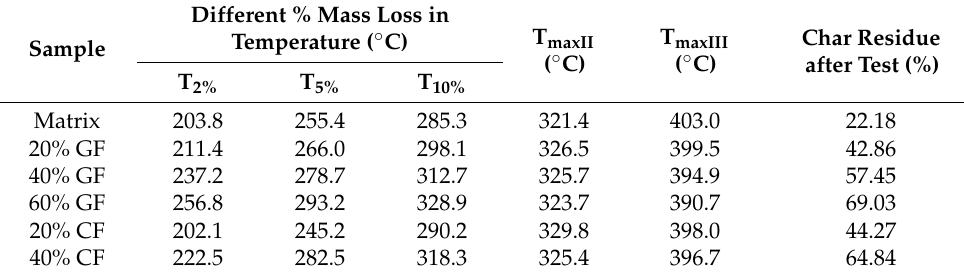
Figure 5. DTG (Derivative Thermogravimetry) curves of composites ( a ) carbon fiber, ( b ) glass fiber. Table 5. Results of thermogravimetric analysis of the obtained materials.